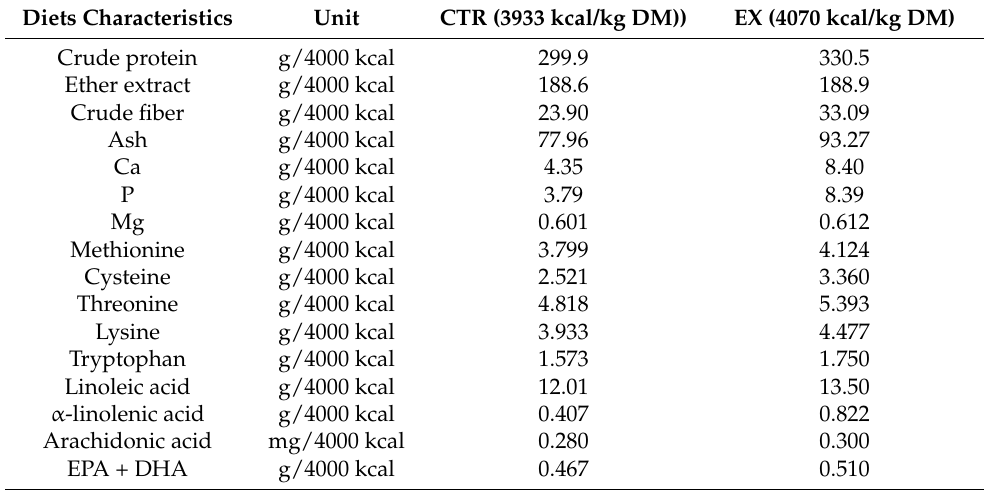
Table 2. Characteristics of the diets Control (CTR) and Experimental (EX) administered to the bitches during the experimental